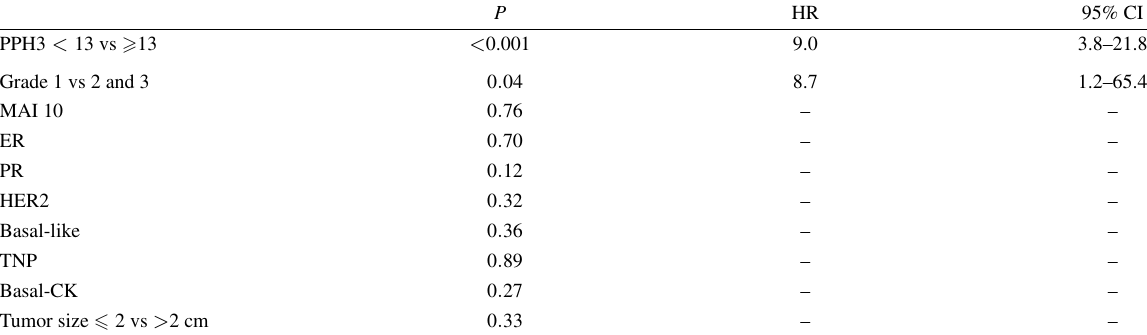
Results of the multivariate survival analysis. Grade 1 versus Grade 2 and 3 have additional prognostic value to PPH3 ( P = 0 . 04) but none of the other features analyzed do ( P > 0 . 05)